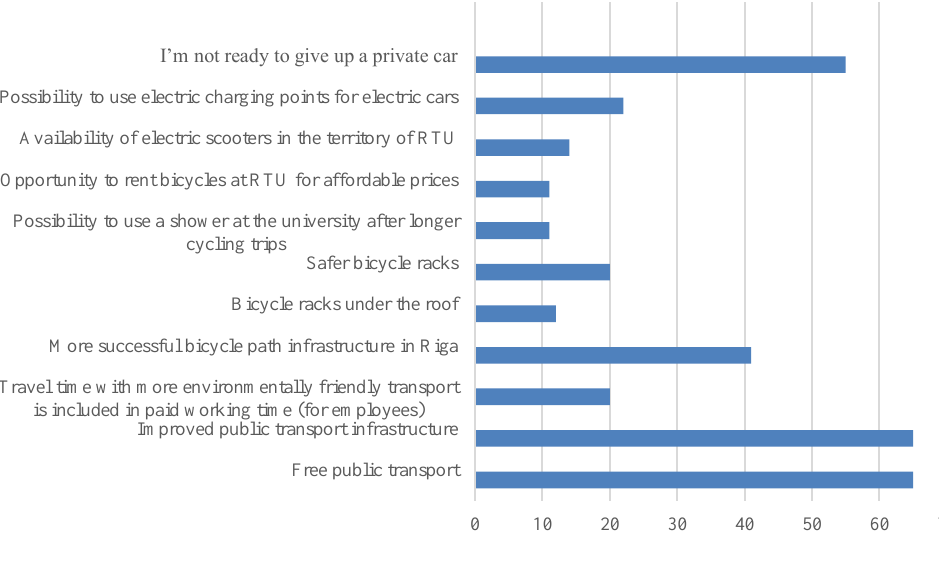
Fig. 6. Answers to the survey's question: ‘If you mostly use a private car (petrol/diesel/gas), what would motivate you the most to use a more environmentally friendly means of